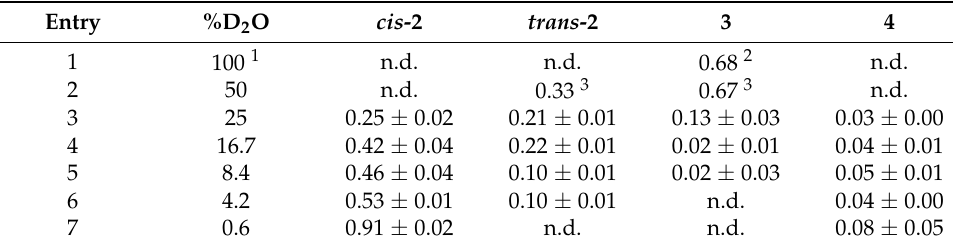
Table 2. Product yields from the conversion of CHN 1 with varying % D 2 O in DMSO- d 6 . Yields are reported as averages with standard deviations obtained from triplicate measurements or not determined (n.d.) because the signal was below detection.